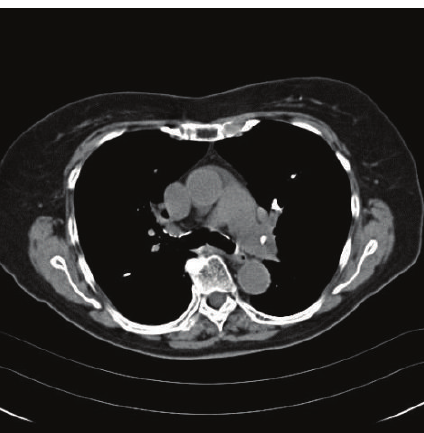
Figure 1: Computed tomography of chest without contrast depict- ing a clear left pulmonary artery filling defect.